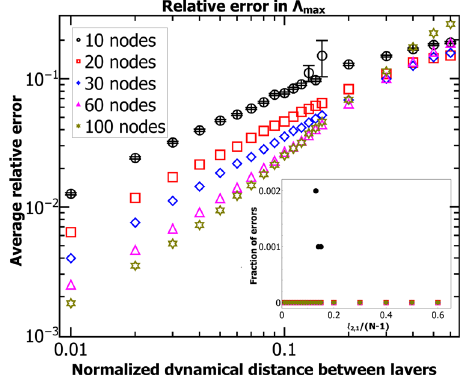
Fig. 1 The accuracy of our theory increases with the ratio of the Fig. 2 Synchronization stability of networks with multiple interaction interaction strengths of the fi rst layer σ 1 to that of the second layer σ 2 . layers is virtually always mean- fi eld. In networks with N nodes per layer, of The relative error in the estimate of the largest Lyapunov exponent Λ for normalized dynamical distances ℓ 2,1 /( N − 1) smaller than 0.1, the max the perturbed system decreases from a maximum of approximately 40% in accuracy of the estimate of the maximum Lyapunov exponent Λ max region 6 ( σ 1 = σ (cid:4) 0 : 0917) to a minimum of approximately 0.7% in region 3 improves with system size. Also, the error in the estimate never increases 2 ( σ 1 = σ (cid:4) 3 : 5). Within each region, the error increases sublinearly with the beyond 0.3, even for very large dynamical distances. Each point is averaged 2 normalized dynamical distance. Each point is averaged over 1000 over 1,000 realizations; when not drawn, error bars are smaller than the realizations; error bars are smaller than the symbol size. Inset: schematic symbol size. Inset: our mean- fi eld theory assesses synchronization stability illustration of the six regions (adapted from del Genio et al. 27 ). Layer 1 is always correctly, with possible occasional exceptions only occurring in very individually stable only when σ 1 is greater than a critical value (red striped small regions); layer 2 is individually stable only when σ 2 lies between two critical values (blue striped regions); region 1 is the only zone of the phase diagram where both layers are already individually stable.